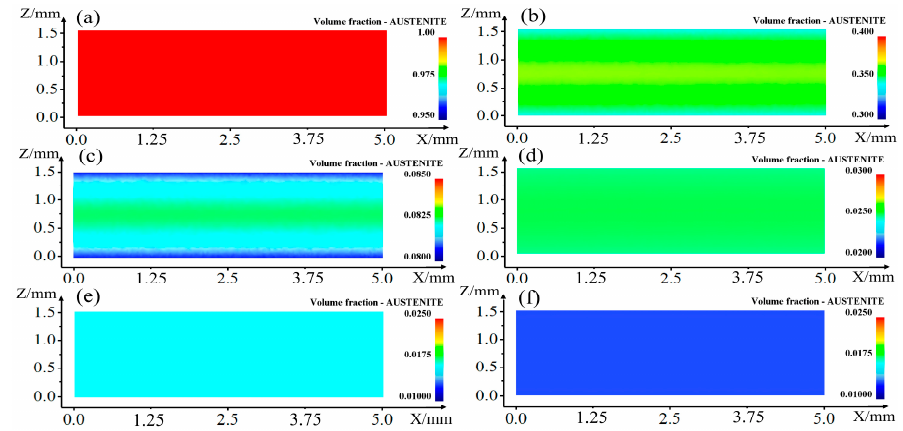
Figure 5. Austenite volume fraction and distribution during quenching process: ( a ) 3 s, ( b ) 6 s, ( c ) 9 s, ( d ) 12 s, ( e ) 15 s and ( f ) 18 s.